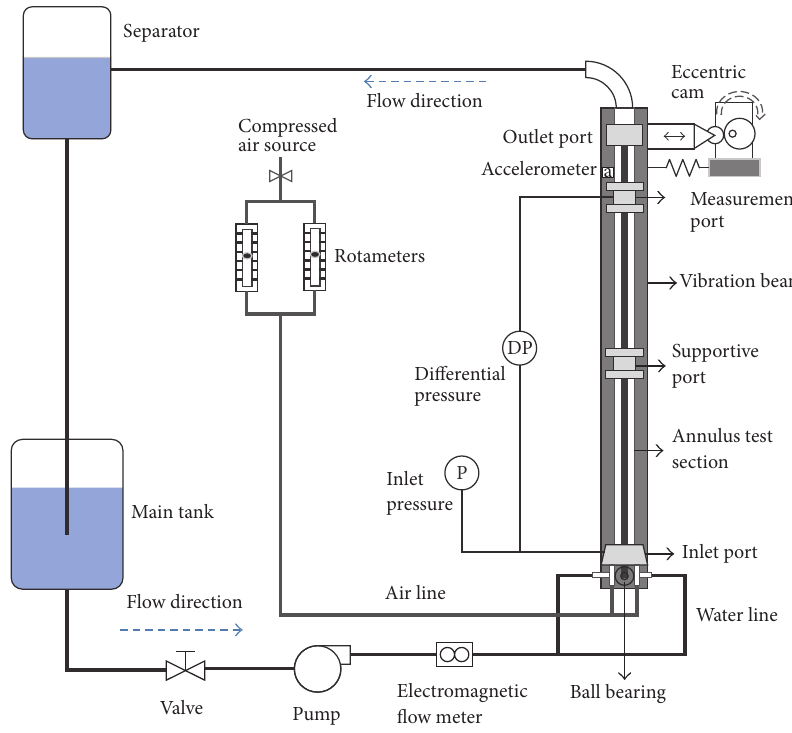
Figure 1: Schematic of experimental